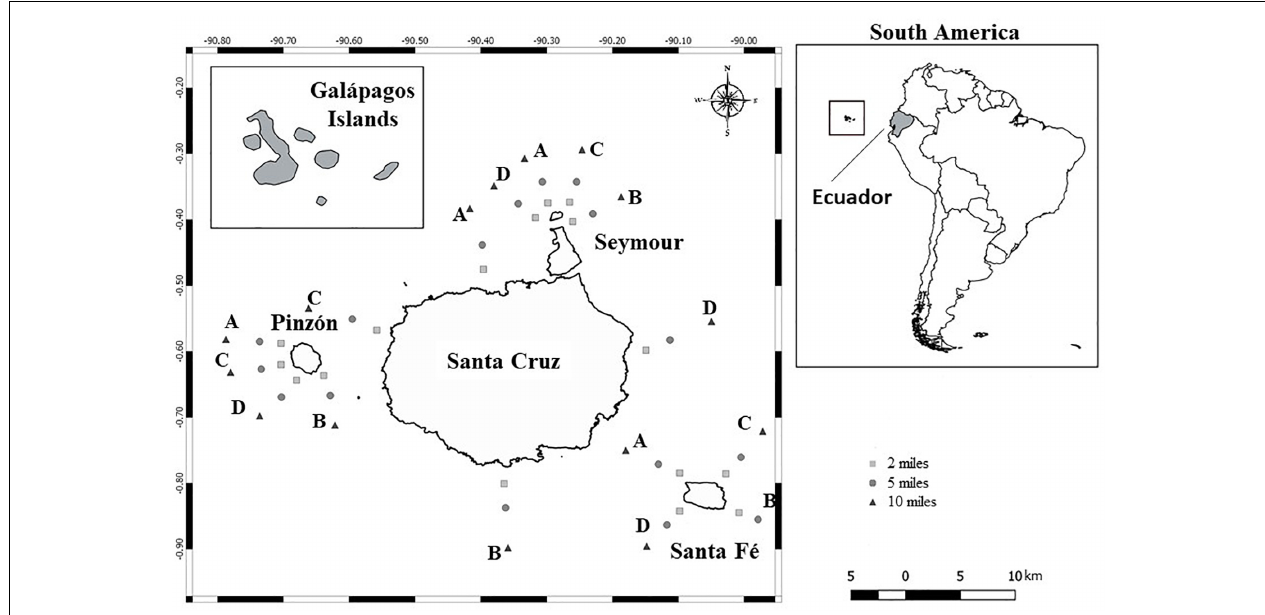
FIGURE 1 | GMR sampling sites: Pinzón, Santa Fé, Santa Cruz, and Seymour Islands. Four transects were performed in each Island at 2, 5, and 10 nm from the coast.